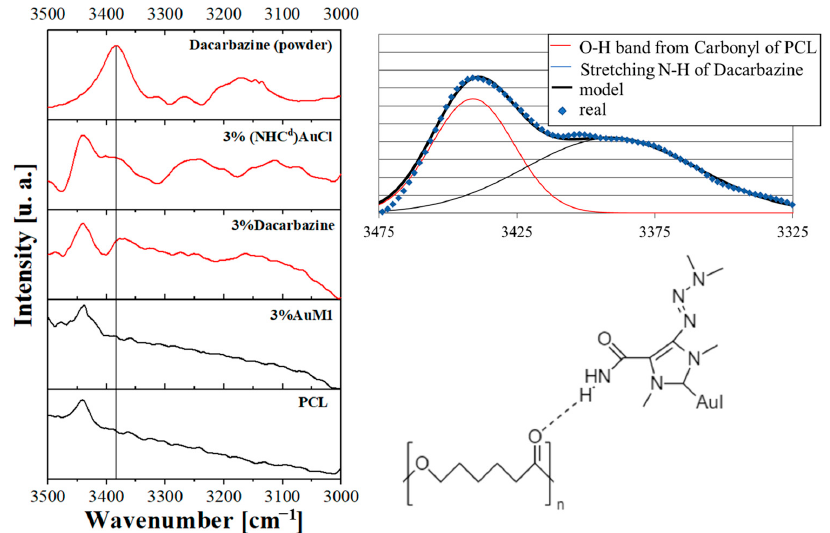
Figure 4. FTIR between 3000–3500 cm − 1 of Dacarbazine powder and the membranes unloaded (PCL) and loaded with AuM1 (3%AuM1), Dacarbazine (3%Dacar) and (NHC d )AuCl (3%(NHC d